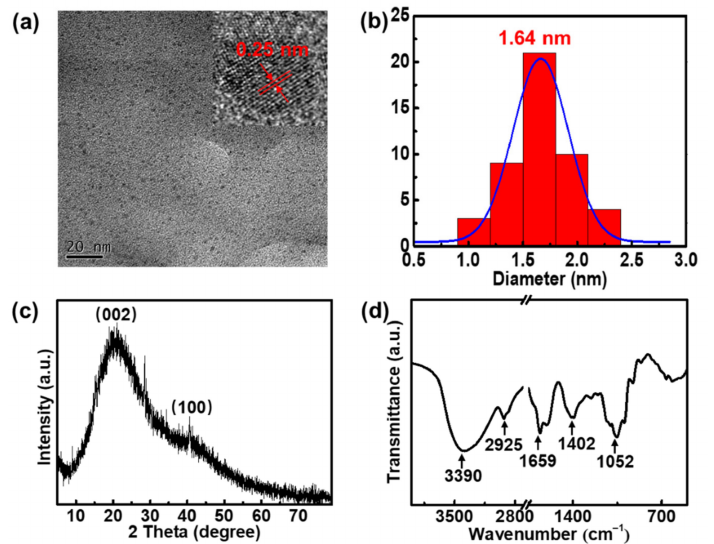
Figure 2. ( a ) TEM image of F-CDs. Inset: HRTEM image of a single dot. ( b ) Diameter distribution of F-CDs; ( c ) XRD pattern of F-CDs. ( d ) FT-IR spectrum of F-CDs.